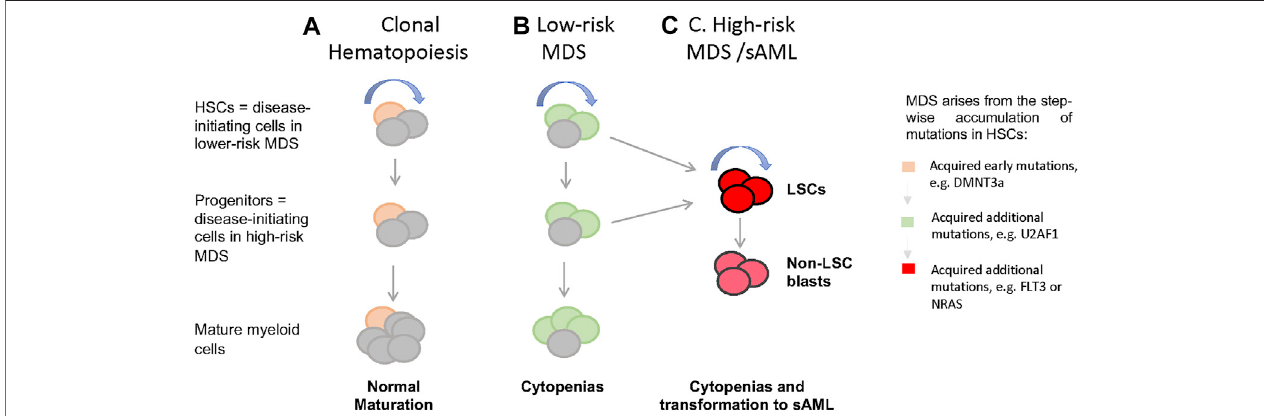
FIGURE 1 | Cellular and genetic hierarchies and disease progression in MDS. (A) In healthy individuals, hemotopoiesis is charcterzied as a hierarchy in which self- renewing HSCs give rise to non-self-renewal multipotent and commited progintors and eventually mature cells. When aged HSCs acquire somatic mutations and give rise clones with enhanced self-renewal (yellow), thsi is detectable in the peripheral blood as clonal hematopoiesis (CH), which often characterized by mutations in genes such asDMNT3a,TET,andASXL1. (B) when HSCsharboringCH associatedmutationsacquireadditional mutationsingenessuch asU2AF1, SRF2,and SF3B1, this leads to the formation of MSD stem cells, MDS-SCs (green). In low-risk MDS, disease stem cells immunophenotypically resemble normal HSCs, while in high-risk disease with excess blasts, resmbles committed myeloid progenitors. (C) It is presumed that acquisitions of lesions such as FLT3 and NRAS mutations in HSCs or committed proginitors drive the formation of leukemia stem cells (LSCs) and non-self-renewing blasts that accumalate in high-risk MDS and sAML. LSCs immunophenotypically resemble committed progenitors. (curved blue arrow (cid:2)